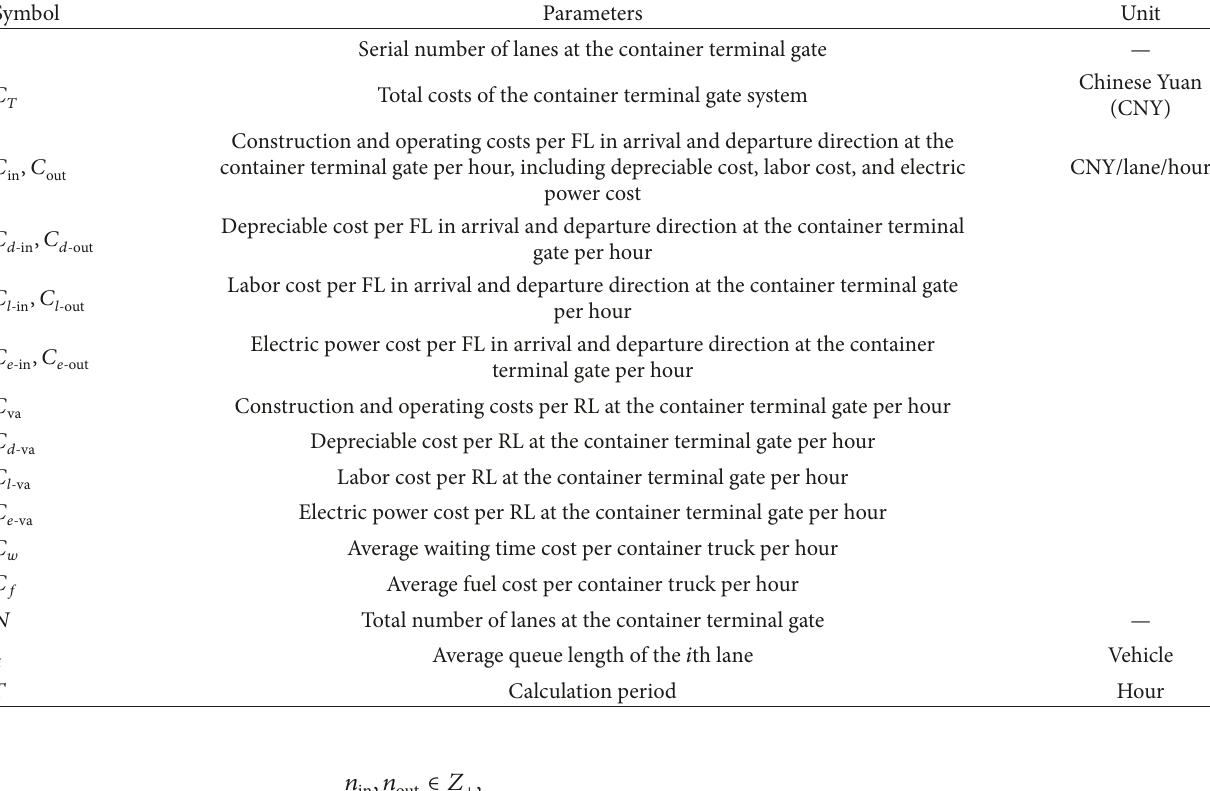
Table 1: Parameters of the optimization